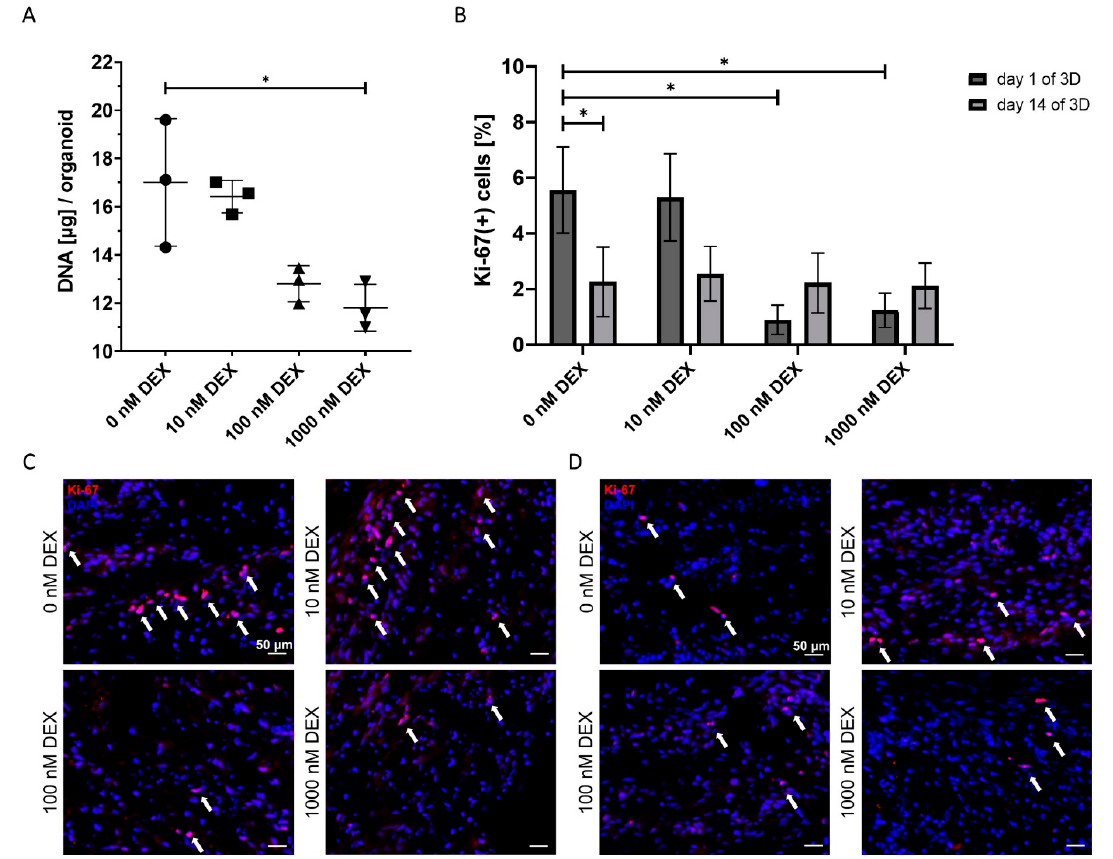
Figure 5. Analyses of organoid DNA content and incidence of proliferative cells. ( A ) PicoGreen-based DNA quantification directly after organoid formation (d0). Lines show mean values ± SD for n = 3 donors and each dot indicates individual donor; * p < 0.05. ( B ) Quantification at d1 and d14 of Ki-67-positive cells in percentage to DAPI-positive nuclei of all organoid groups. Bars show mean values ± SD for n = 3 donors; * p < 0.05. ( C , D ) Representative fluorescent images of Ki-67 staining at d1 and d14 of 3D maturation, respectively. Cell nuclei appear in blue, while Ki-67-positive cells in red. Arrows indicate single or clusters of Ki-67-positive cells.